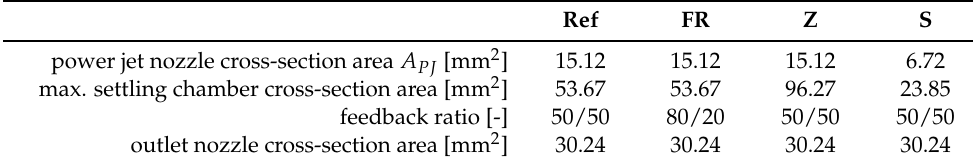
Table 1. Main dimensions of the oscillator